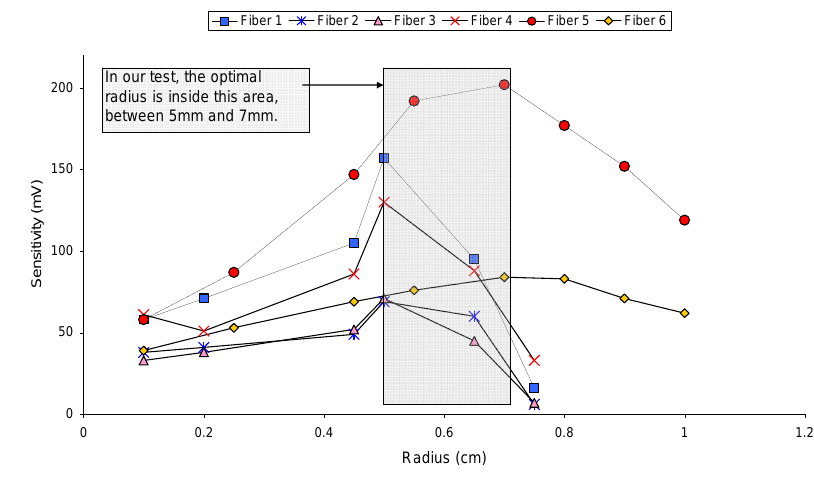
Figure 4. Determination of the radius length that provides the highest sensitivity.